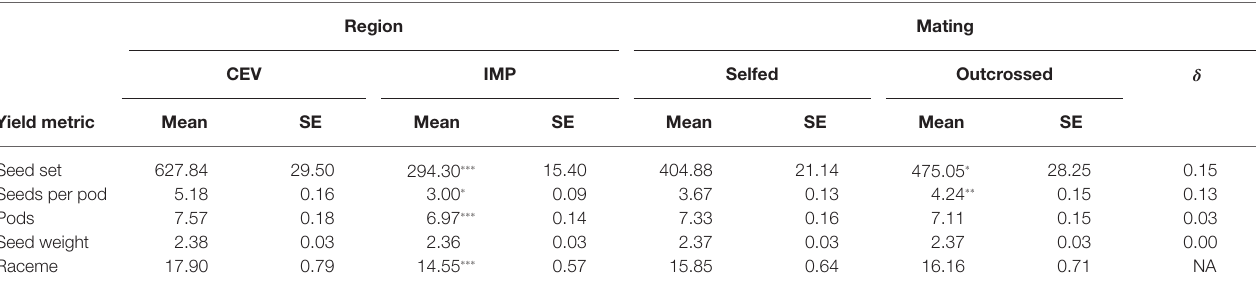
TABLE 4 | Seed yield metrics per region (CEV and IMP) and per mating system (selfed and outcrossed). Region